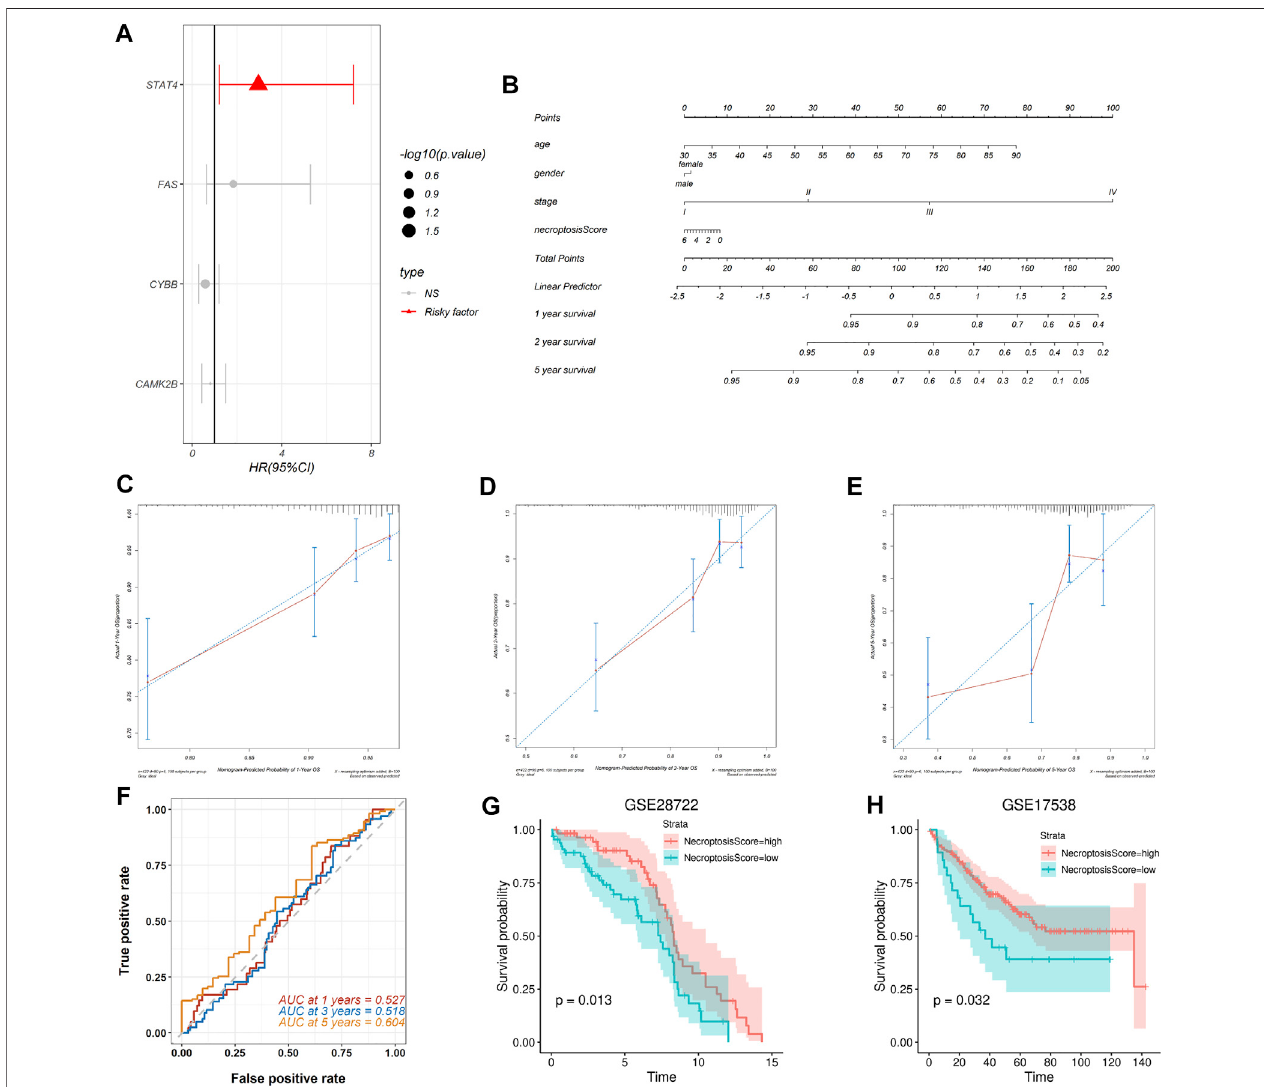
FIGURE5| Constructionandvalidationofthenecroptosisprognosismodelbasedonthenecroptosisgenesignature. (A) Theforestplotshowsmulti-Coxanalysis resultbetweenthefournecroptosissignaturegenesandOS. (B) Thenomogramintegratesage,gender,tumorstage,andnecroptosisscoretopredicttheprobabilityof the 1-, 2-, and 5-year OS. (C,D) The calibration curves for 1-, 2-, and 5-year OS, respectively. (E) The 1-, 3-, and 5-year time-dependent ROC for necroptosis signature survival prediction in the TCGA-COAD database, respectively. (F – H) Validation of the necroptosis signature in predicting the prognosis of patients in GSE28722 and GSE17538 datasets